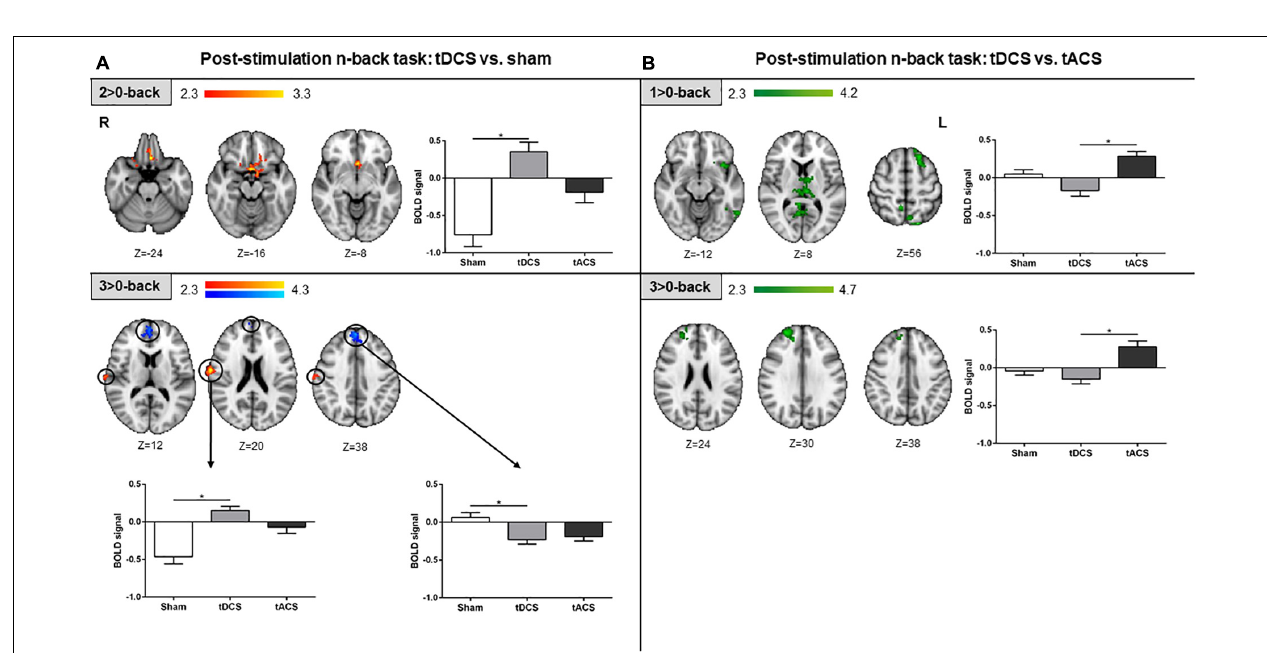
FIGURE 5 | Online fMRI n-back task results. (A) tACS vs. sham results are shown in red-yellow. (B) tDCS vs. tACS results are shown in green. Left: statistically significant fMRI activity maps on the standard MNI for each contrast of interest and group comparison. Right: plots of mean BOLD signal values at the fMRI clusters considering sham, tDCS and tACS where significant differences between groups were found. Data are presented as mean with SEM . tACS, transcranial alternating current stimulation; tDCS, transcranial direct current stimulation; BOLD, blood oxygen level dependent.